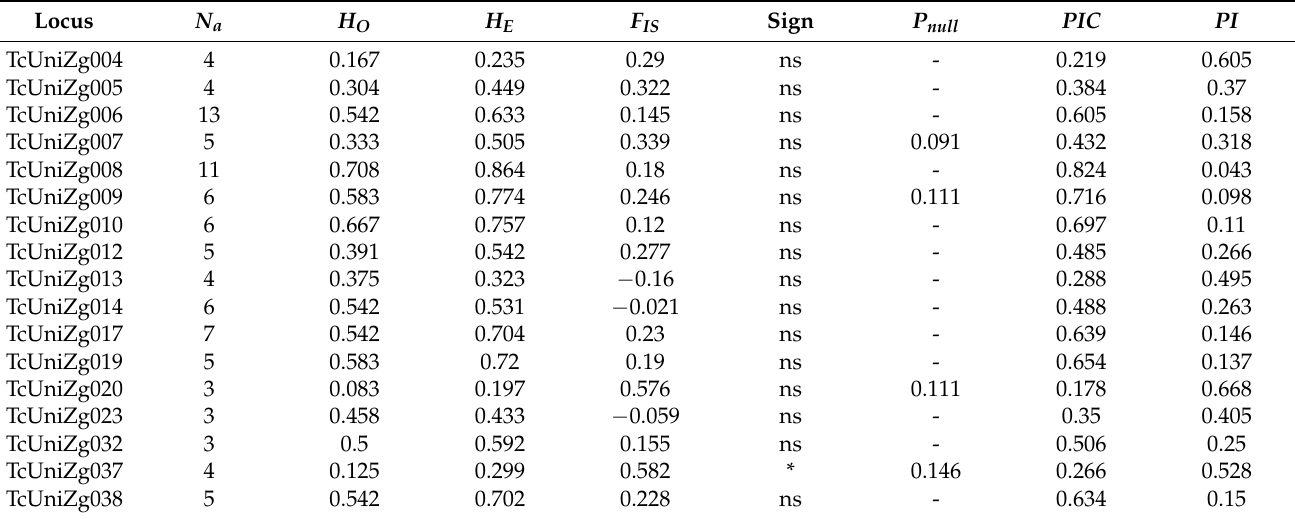
Table 3. Characterization of developed microsatellite markers of T. cinerariifolium based on molecular analysis of 20 samples from Hvar population.